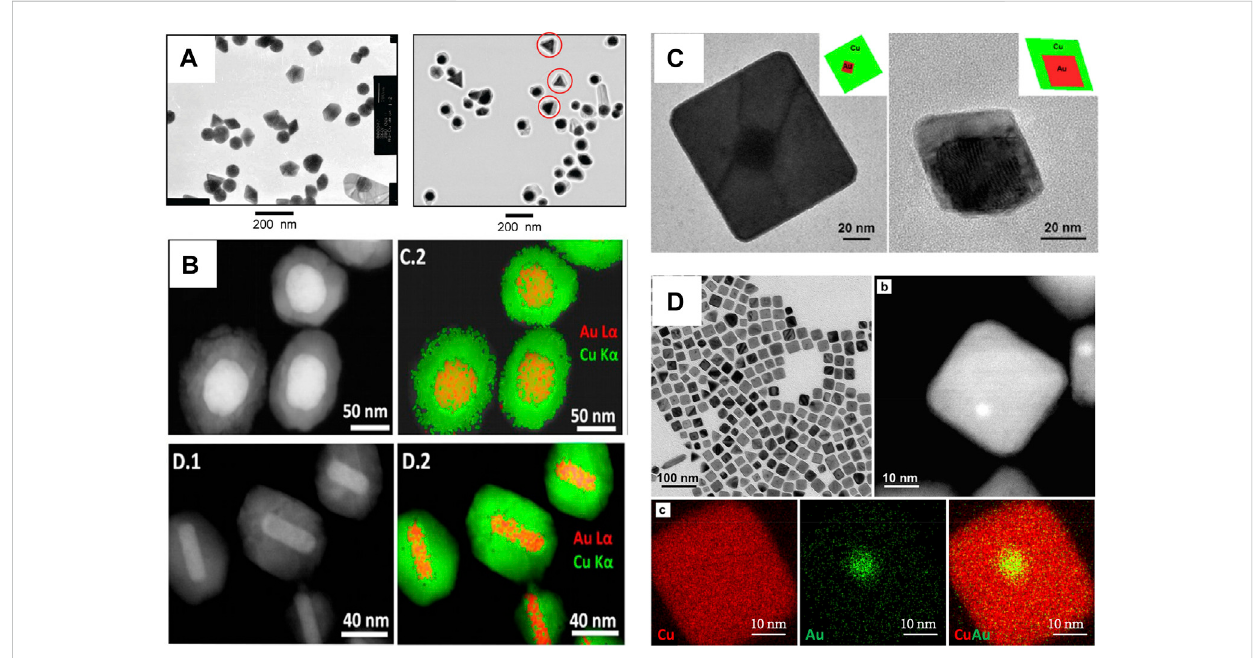
FIGURE 2 (A) TEM images of Au nanostructures and Au – Cu core-shell nanostructures (Tsuji et al., 2010). (B) HAADF-STEM images and STEM-EDS elemental maps of Au – Cu core-shell nanostructures (Alvarez-Paneque et al., 2012). (C) TEM images of the Au – Cu core − shell nanocubes and octahedra with Au octahedra nanocrystals as seeds (Kim et al., 2014). (D) TEM images and EDX mapping of Au – Cu core – shell nanocubes(Lyu et al.,